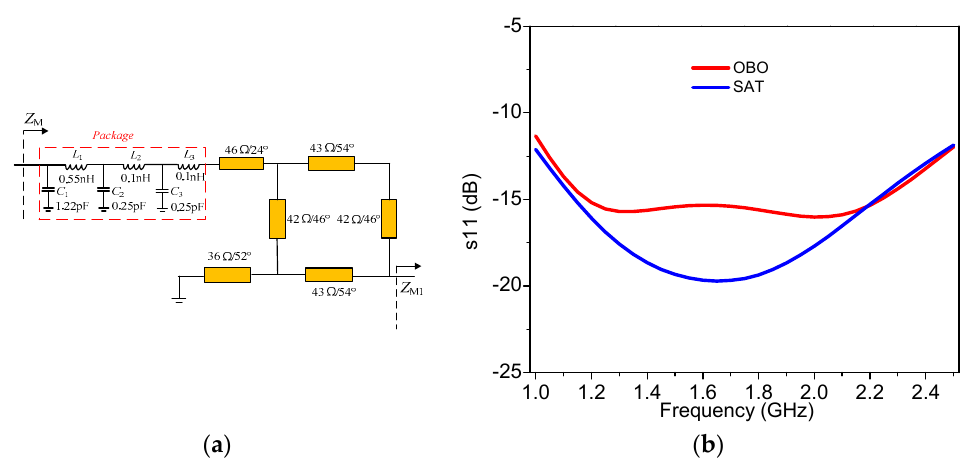
Figure 10. Main PA branch: ( a ) output network of the main PA; ( b ) simulated s11.